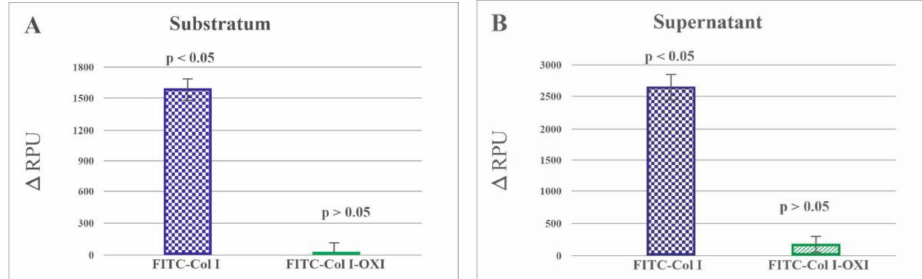
Figure 5. Relative changes in the fluorescence values of substratum-associated ( A ) and spontaneously released ( B ) FITC-Col I after 24 h of incubation with and without cells. The data are presented as RPU subtracting the signal from the samples with cells from the cell-free ones, directly characterizing the proteolytic de-quenching caused by the